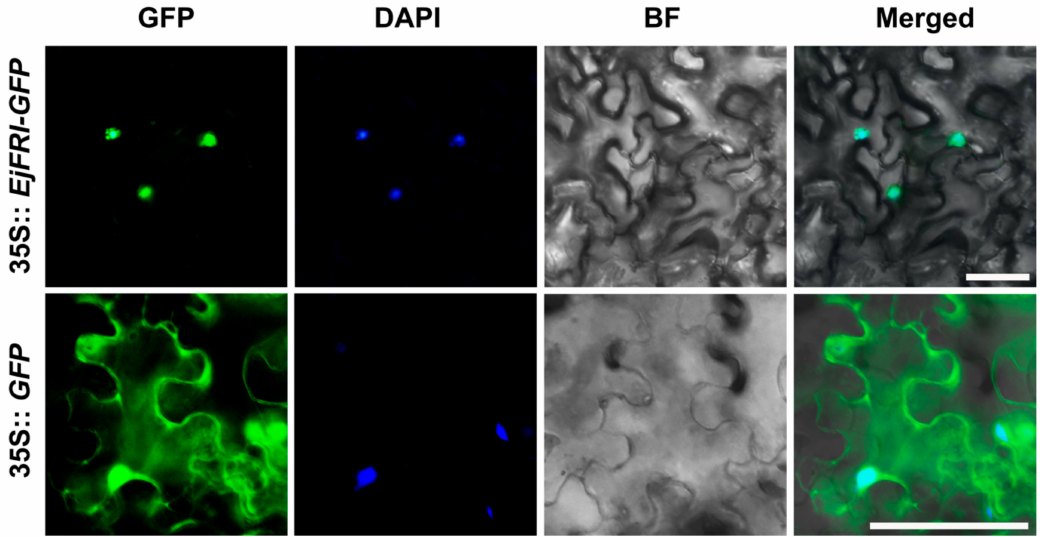
Figure 4. Subcellular localization of EjFRI. GFP, GFP fluorescence; 4,6-diamidino-2-phenylindole (DAPI) staining indicates nuclear localization; BF, bright-field; Merged, merged image of GFP and DAPI. Scale bars = 20 µ m in 35S:: EjFRI-GFP and 50 µ m in 35S:: GFP